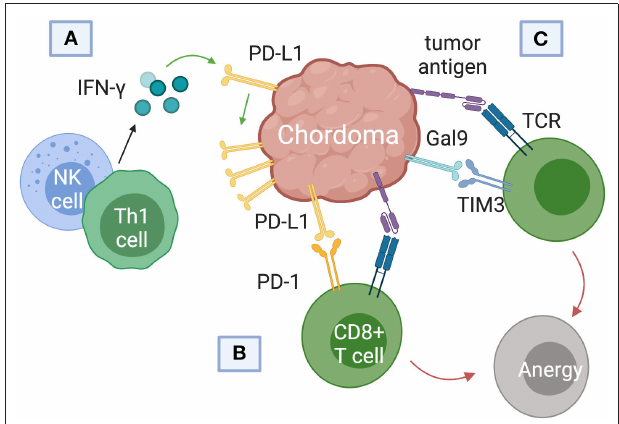
FIGURE 4 | Immune checkpoint pathways implicated in chordoma pathogenesis and survival. (A) Interferon-gamma released from natural killer (NK) cells and helper CD4 + T (Th1) cells was found to upregulate programmed death ligand (PD-L1) expression in chordomas. (B) PD-L1 binds the programmed cell death protein 1 (PD-1) on cytotoxic T cells, inducing T cell anergy. (C) Chordomas also induce immunosuppression via the Gal9 immune-checkpoint protein binding to TIM3 on cytotoxic T